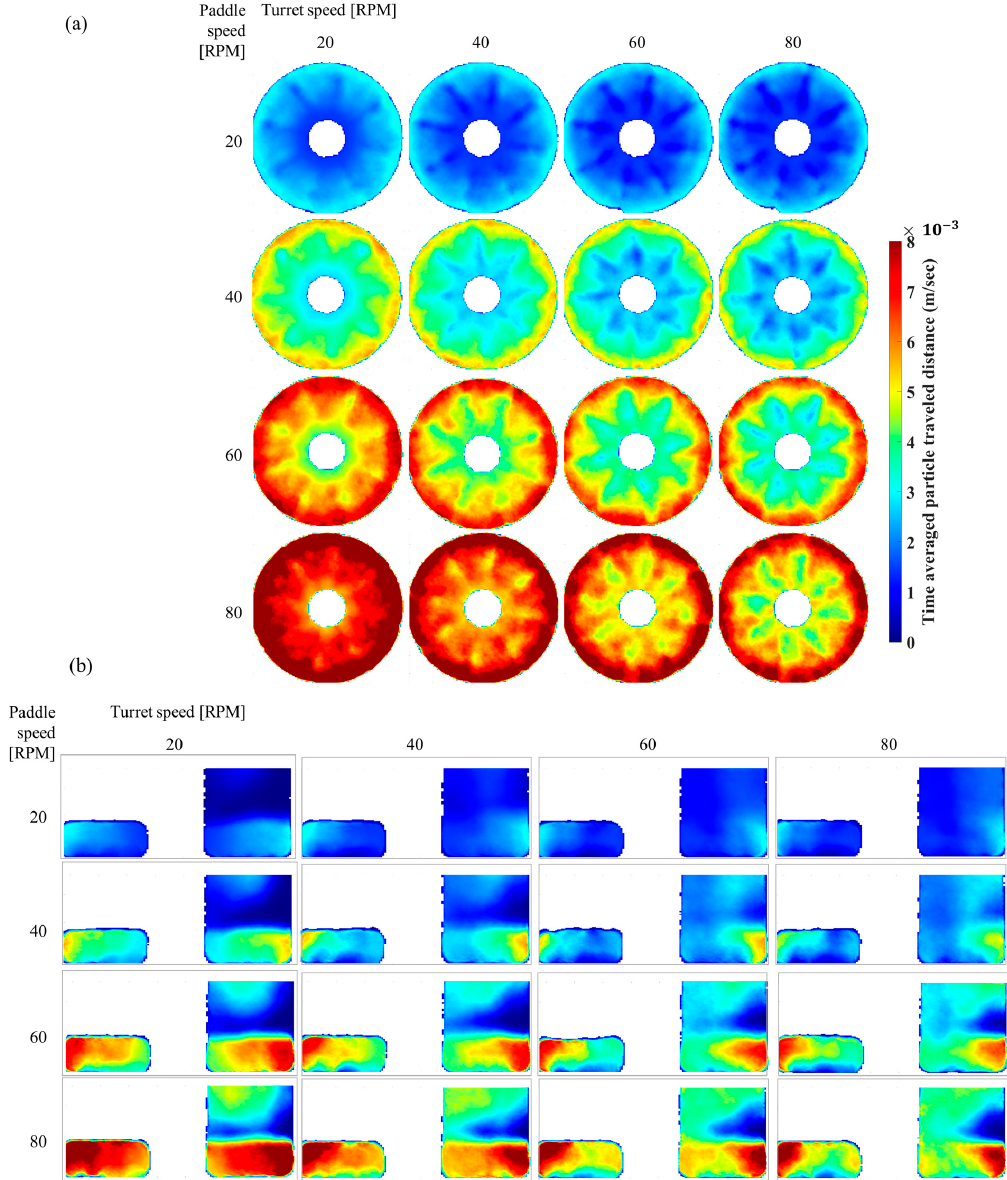
Figure 8. Continuous spatial plots showing averaged particle distance traveled in the feed frame where each column corresponds to a different turret speed and each row corresponds to a different paddle speed: ( a ) top view plane at 16 different paddle and turret speeds; ( b ) side view plane at 16 different paddle and turret speeds (left: half of the chamber; right: half of the chamber and the hopper). Blue color indicates smaller particle traveled distance, and red color indicates larger particle traveled distance.